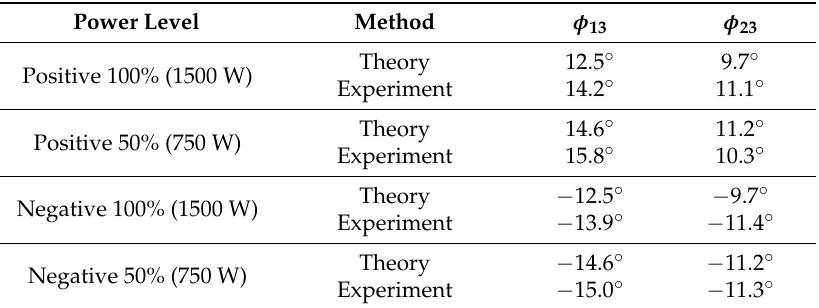
Table 2. Comparison of phase shift angles from theoretical calculation and experiment.